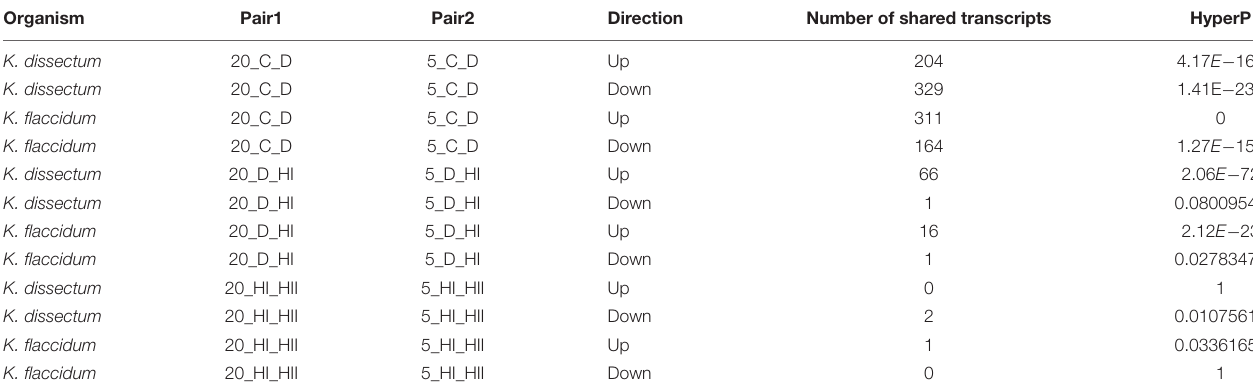
TABLE 1 | Number of regulated genes shared between different treatments. Organism Pair1 Pair2 Direction Number of shared transcripts HyperP